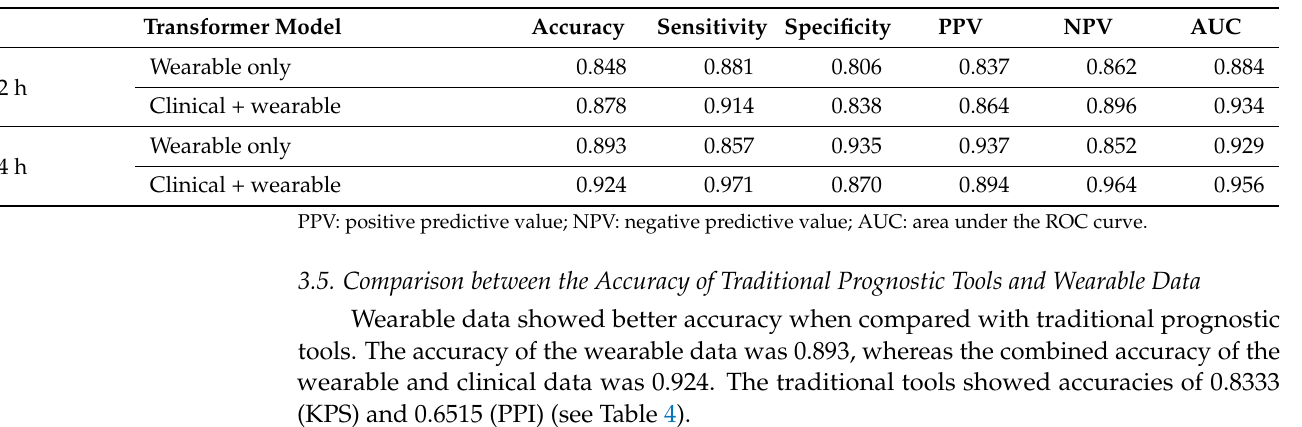
Table 3. Performance of transformer model using the wearable data and the combined data of wearable and clinical data from 12 and 24 h data.